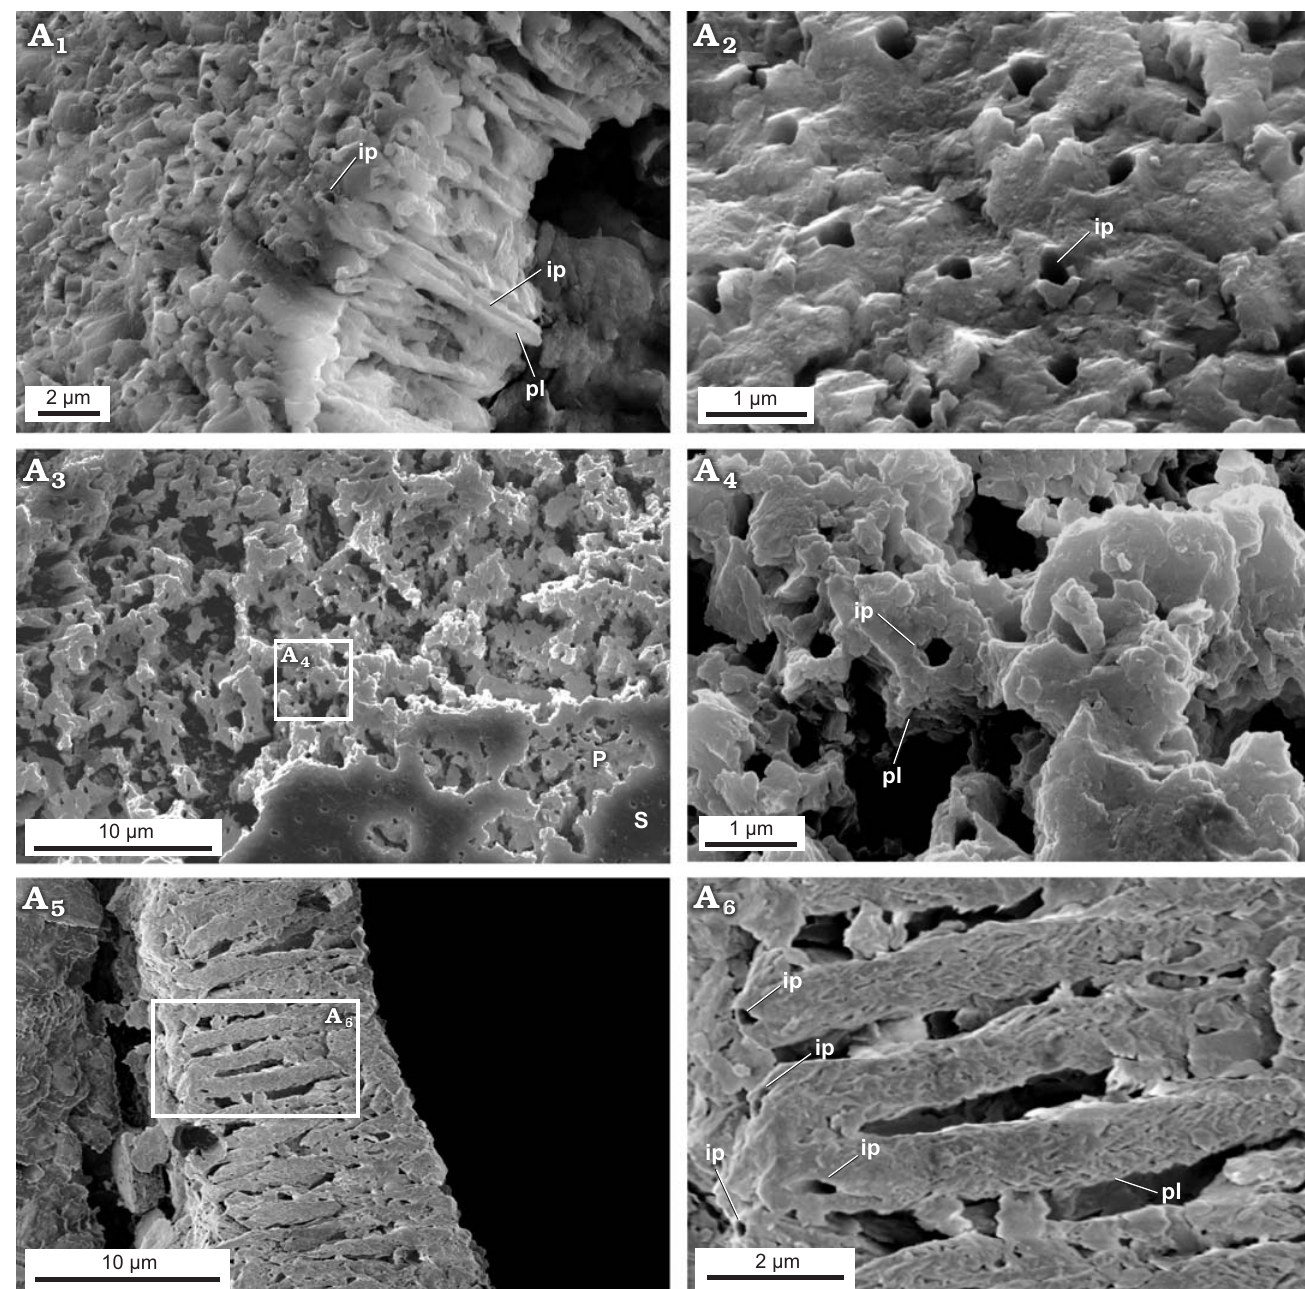
Fig. 6. FESEM images of the test structure in Epistomina nuda Terquem, 1883, MWGUW ZI/67/54/20 (Robertinida, Globothalamea) from the Jurassic of Gnaszyn, Poland. Side view of the test showing finely perforated test surface and cross section of columnar domain (A 1 ); front view of the test surface (A 2 ); front view of the outer test surface showing a well-preserved, smooth (S) and slightly abraded (P) outer test surface (A 3 ), significantly magnified view of abraded test surface exposing columnar domain (A 4 ); cross section of the test showing pillar unit composition (columnar domain) (A 5 ); detail of the columnal domain (A 6 ). Abbreviations: ip, inner pores, pl, pillar.